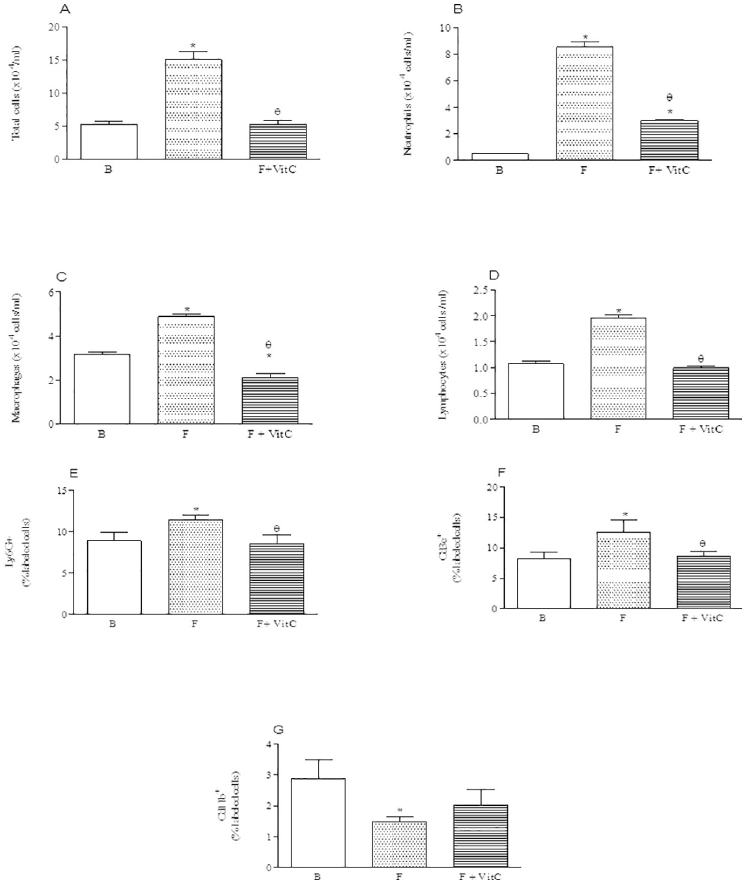
Fig 1. Vitamin C treatment reduces cell influx in the BALF of PQ-induced fibrosis. Groups of mice were submitted to PQ or vehicle injection and after 7 days the animals were treated with vitamin C or vehicle daily until day 14th. Twenty-four hours after the last vitamin C injection the total number and differential cells recovered in the bronchoalveolar lavage was determined. Data represent the mean ± SEM of 6 animals. � P < 0.05 in relation to B group; θ P < 0.05 in relation to F group. PQ administration reduced the percentage of alveolar dendritic cells into the BALF when com- pared to basal group and vitamin C did not modify this reduction.